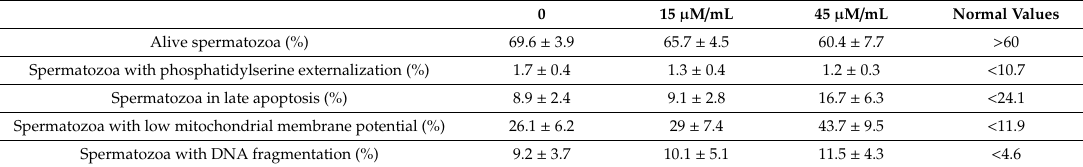
Table 2. E ff ects of increasing concentrations of benzo– α –pyrene (BaP) on bio-functional sperm parameters. No statistically significant e ff ect of BaP was observed for these